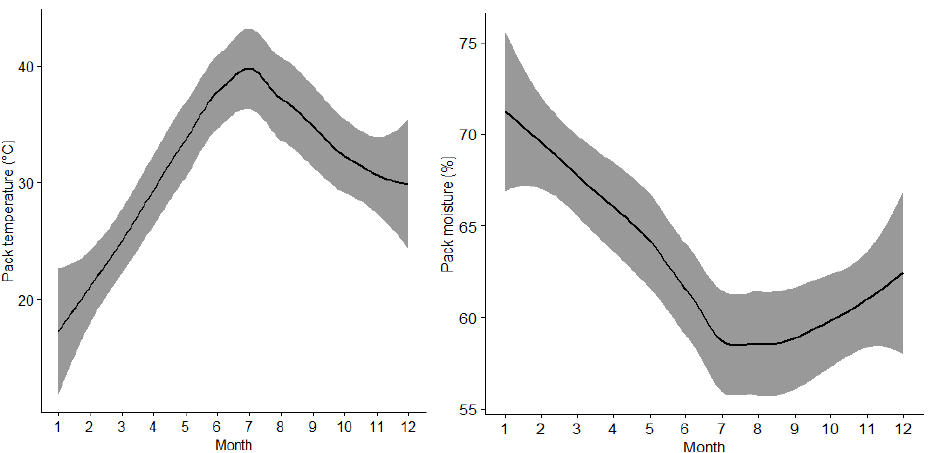
Figure 8. Development of the average and range in temperature ( left ) and the moisture content ( right ) at 20 cm deep in 22 composting bedded-pack’s over the year. Source: Taken from Leso, L., 2021 [22].